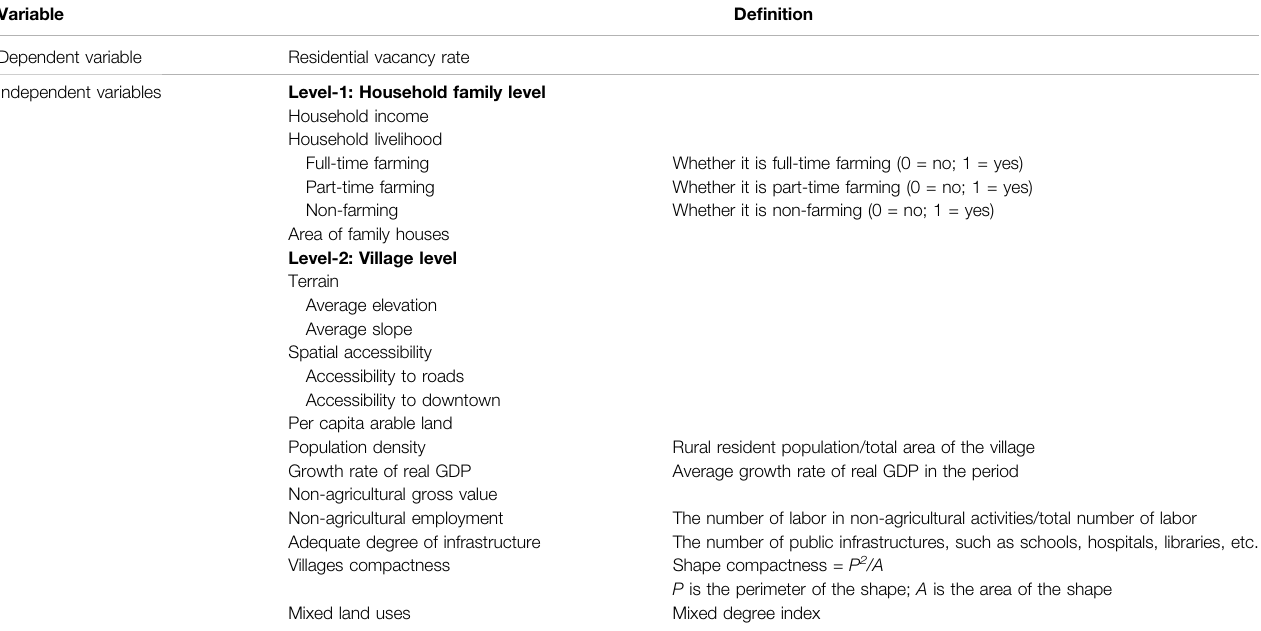
TABLE 3 | Descriptive statistics of the variables used in the regression